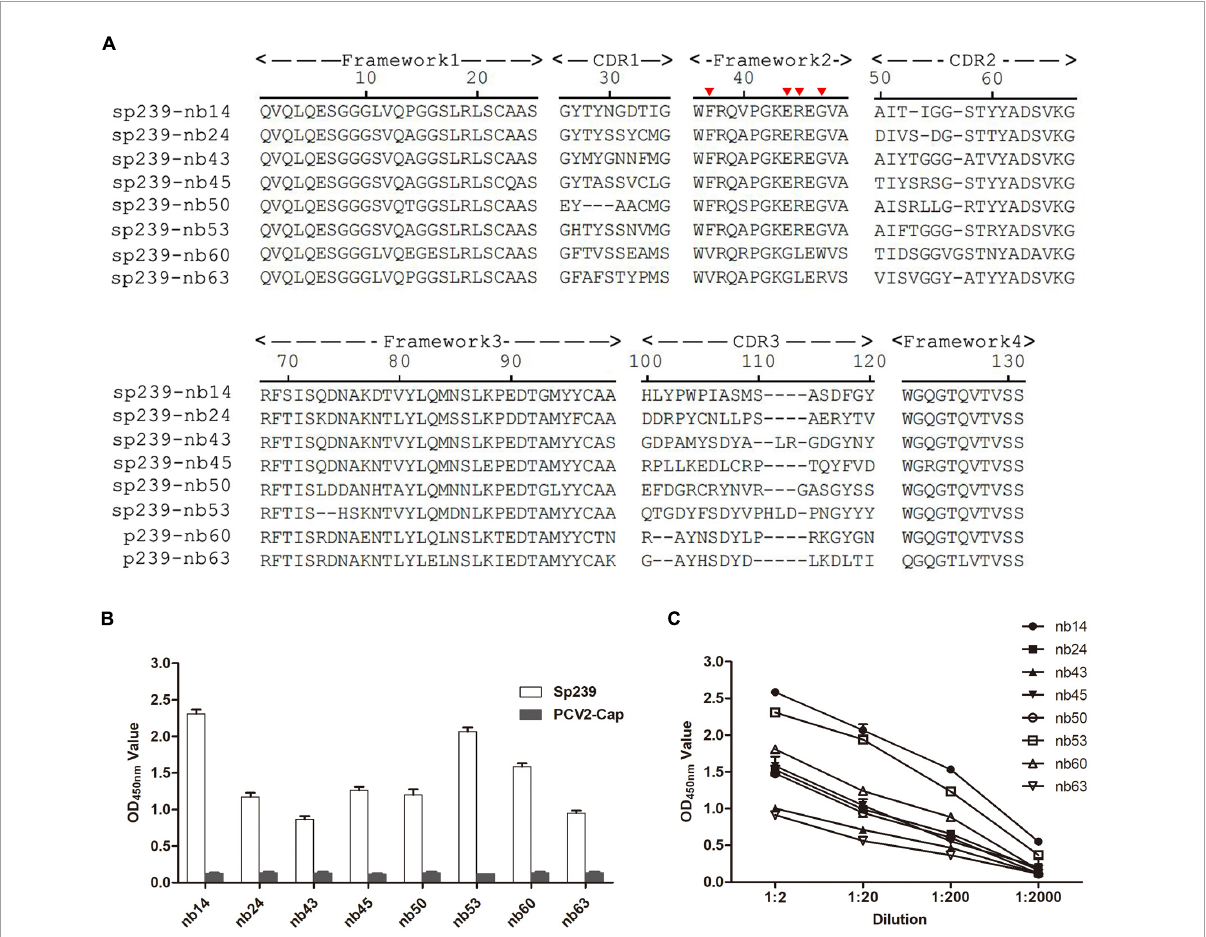
FIGURE1 Screening of nanobodies against the hepatitis E virus (HEV) sp239 protein. (A) Alignment of the amino acid sequences of eight isolated nanobodies. The numbering of frameworks and complementarity-determining regions (CDRs) is based on previous methods (Kabat et al., 1991). (B) The specific binding between sp239 and nanobodies with indirect ELISA. The PCV2-cap protein was used as a control. (C) Titration of the nanobodies. Data were processed with triplicate experiments and are presented as the means ±